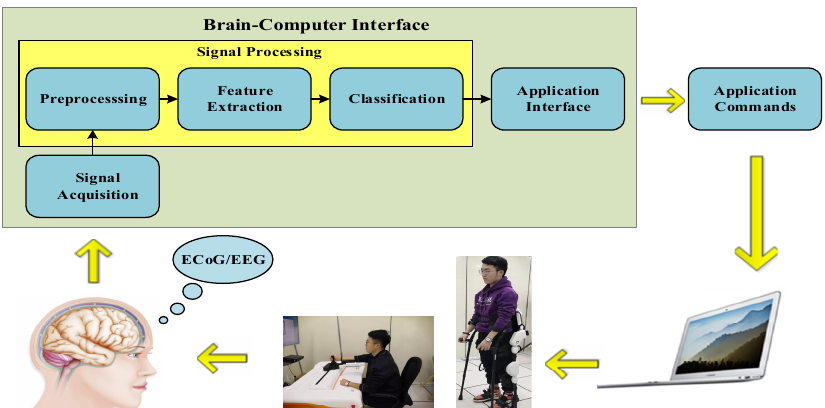
Figure 1. The block diagram of BCI systems for MI classification. The written informed consent has been obtained from the individual for the publication of his identifiable image.